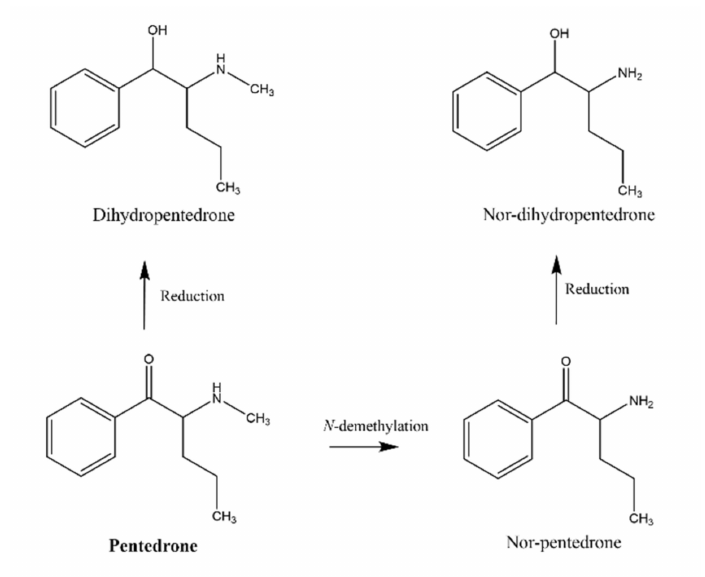
Figure 2. Metabolism of pentedrone in human urine (adapted from